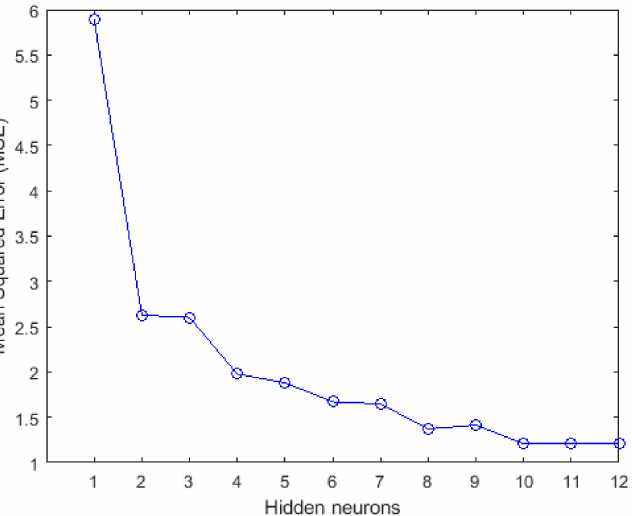
Figure 4. Effect of increasing hidden neurons on the network’s performance to predict the compres- sive